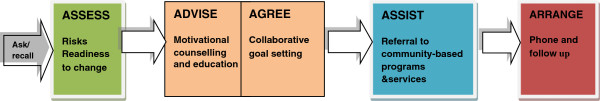
The 5As conceptual model.